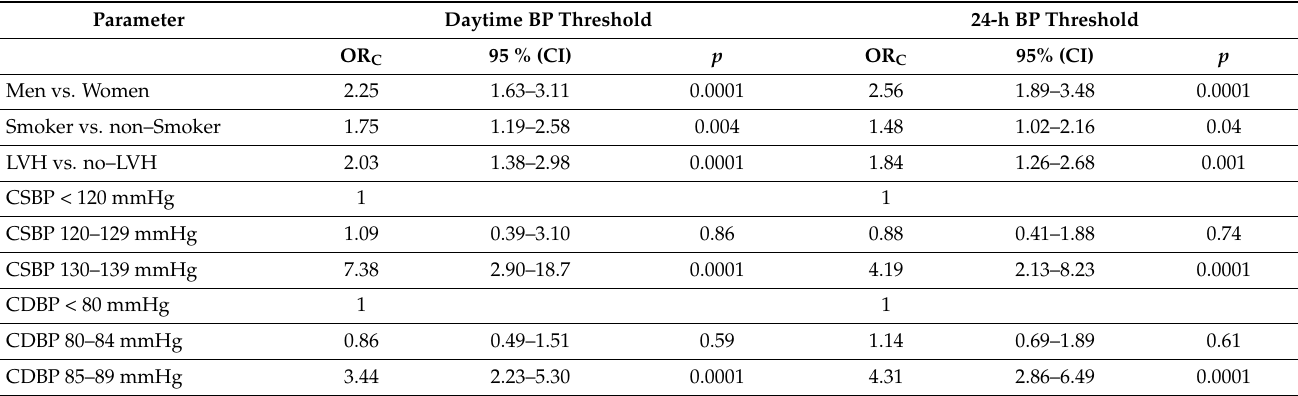
Table 3. Predictors of MUCH by specific thresholds in univariate